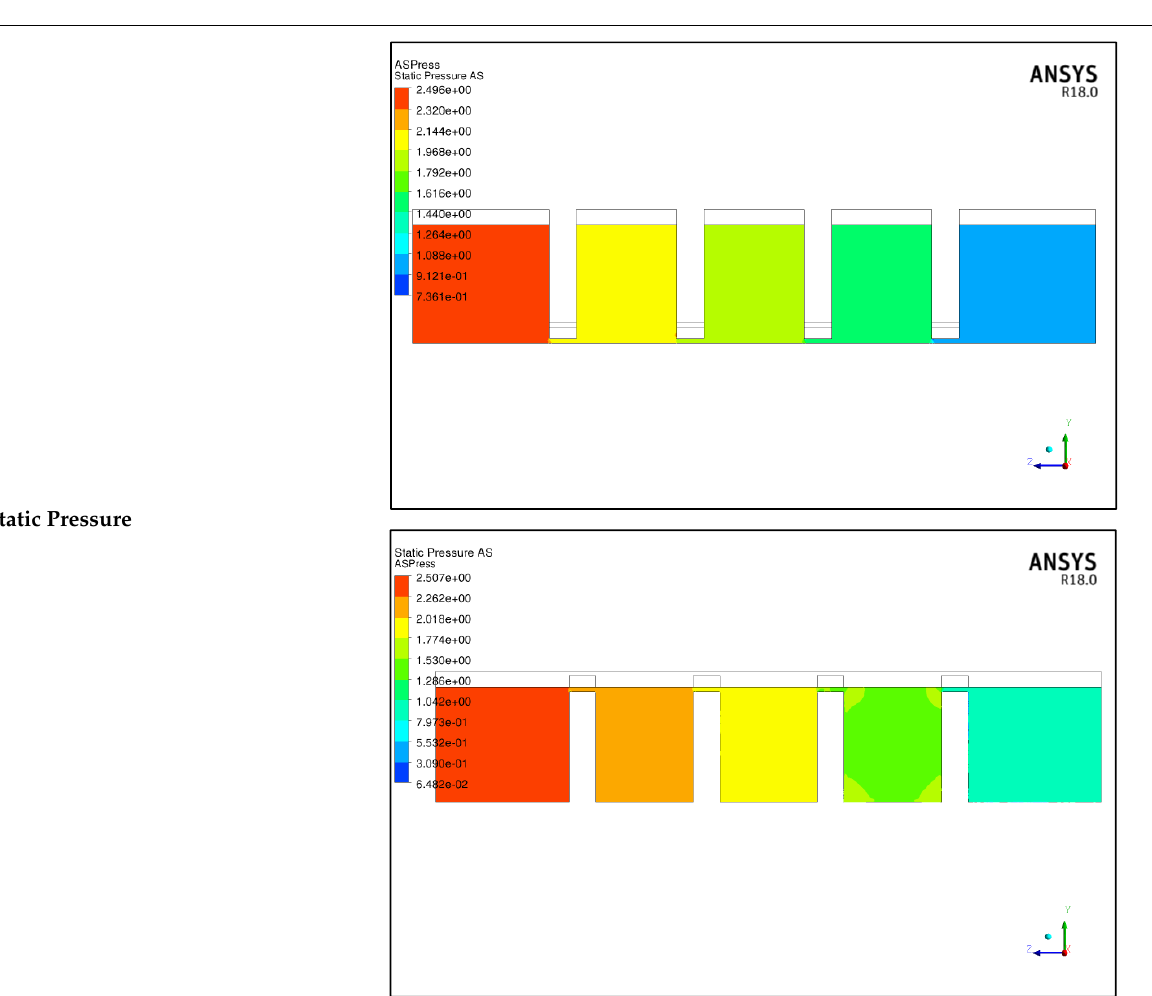
Table A8. Static pressure